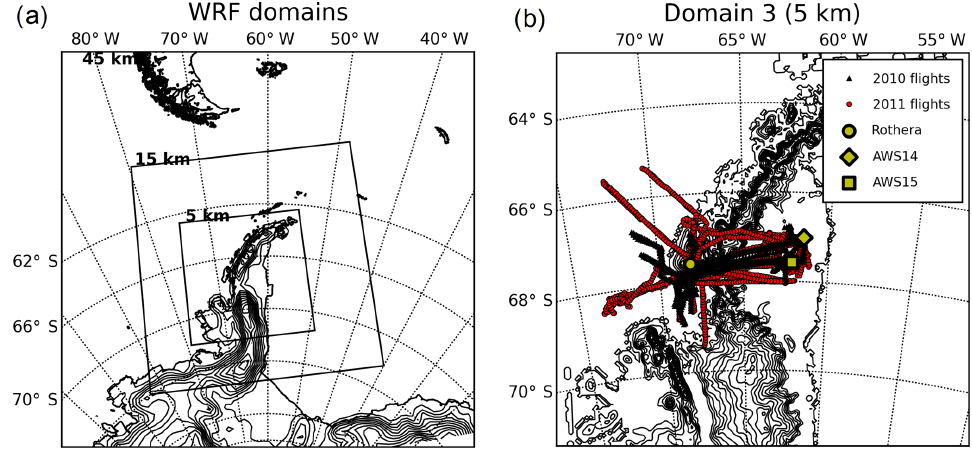
Figure 1. (a) WRF configurations for the three domains used for all simulations and (b) close-up on the highest-resolution domain with detailed topography from Fretwell et al. (2013). The black triangles indicate the flight tracks of the 2010 campaign, while the red circles indicate the flight tracks of the 2011 campaign. The other markers indicate Rothera Research Station (circle) and the automatic weather stations (AWSs) 14 (diamond) and 15 (square) located on the Larsen C Ice Shelf.